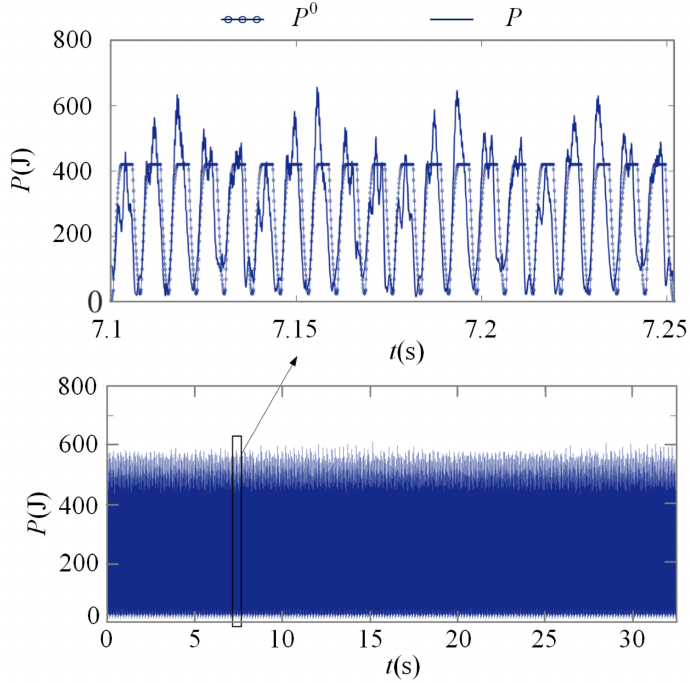
Figure 8. Main cutting force energy consumption of the milling cutter.